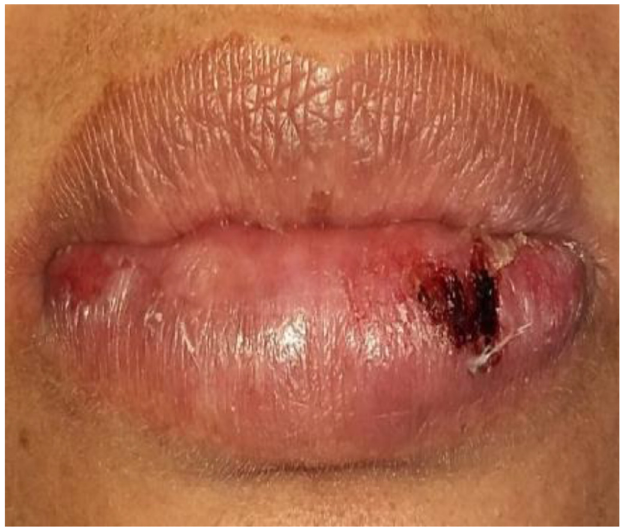
Fig. 4. Swelling and atrophic mucosa of the lower lip with erosion, fi ssures and crusted areas. Lesions are surrounded by lacy white reticular